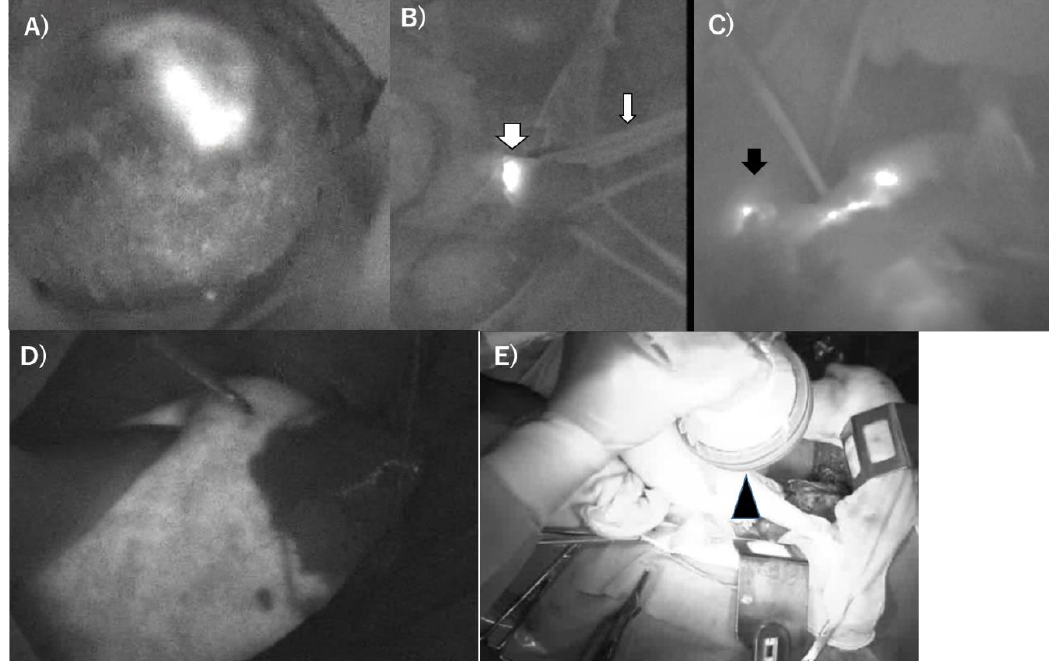
Figure 3. Representative image of the ICG-photodynamic eye image during operation in a hepatocellular carcinoma patient, which showed ( A ) fluorescence of the main HCC and ( B ) portal vein tumor thrombus in the right portal vein (thick white arrow). The thin arrow showed a taped each portal vein and trunk. ( C ) A case of hepatic venous tumor thrombus (black arrow). ( D ) Identification of anatomical demarcation border. ( E ) Observation by the ICG-PDE camera at operative field (Black arrowhead, Hamamatsu Photonics, Hamamatsu, Japan).